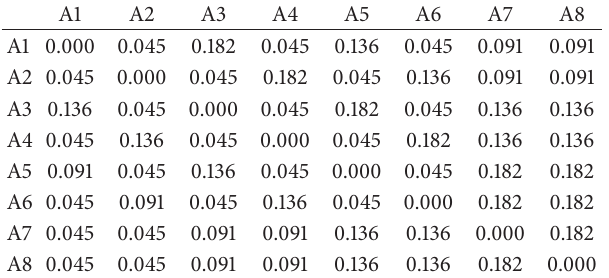
Table 9: Initial direct-relation matrix of model